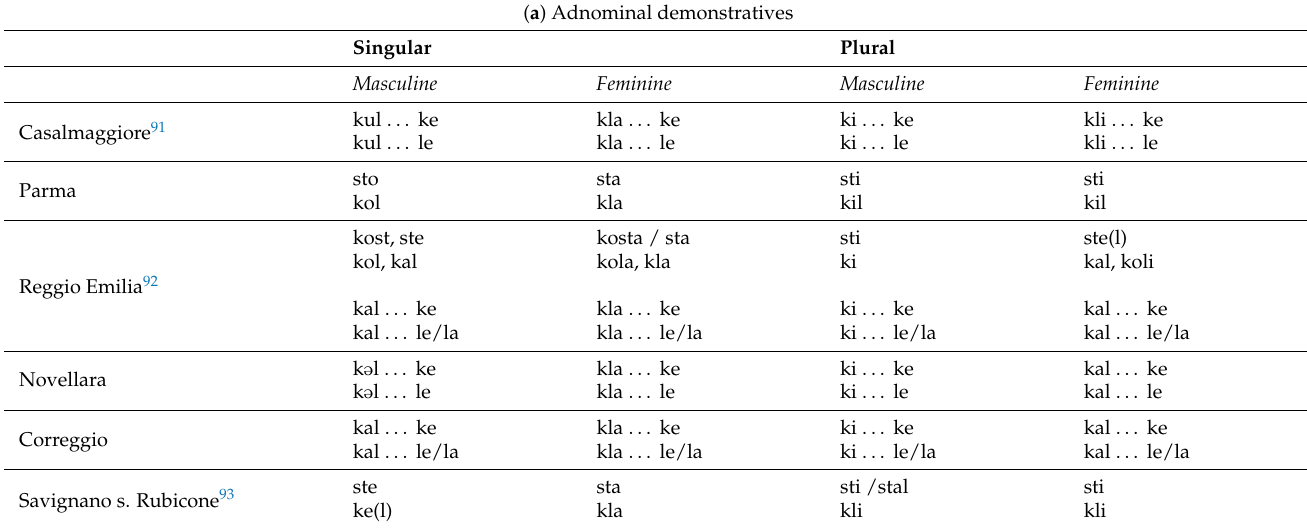
Table A2. (a) Adnominal demonstratives. (b) Pronominal demonstratives. ( a ) Adnominal